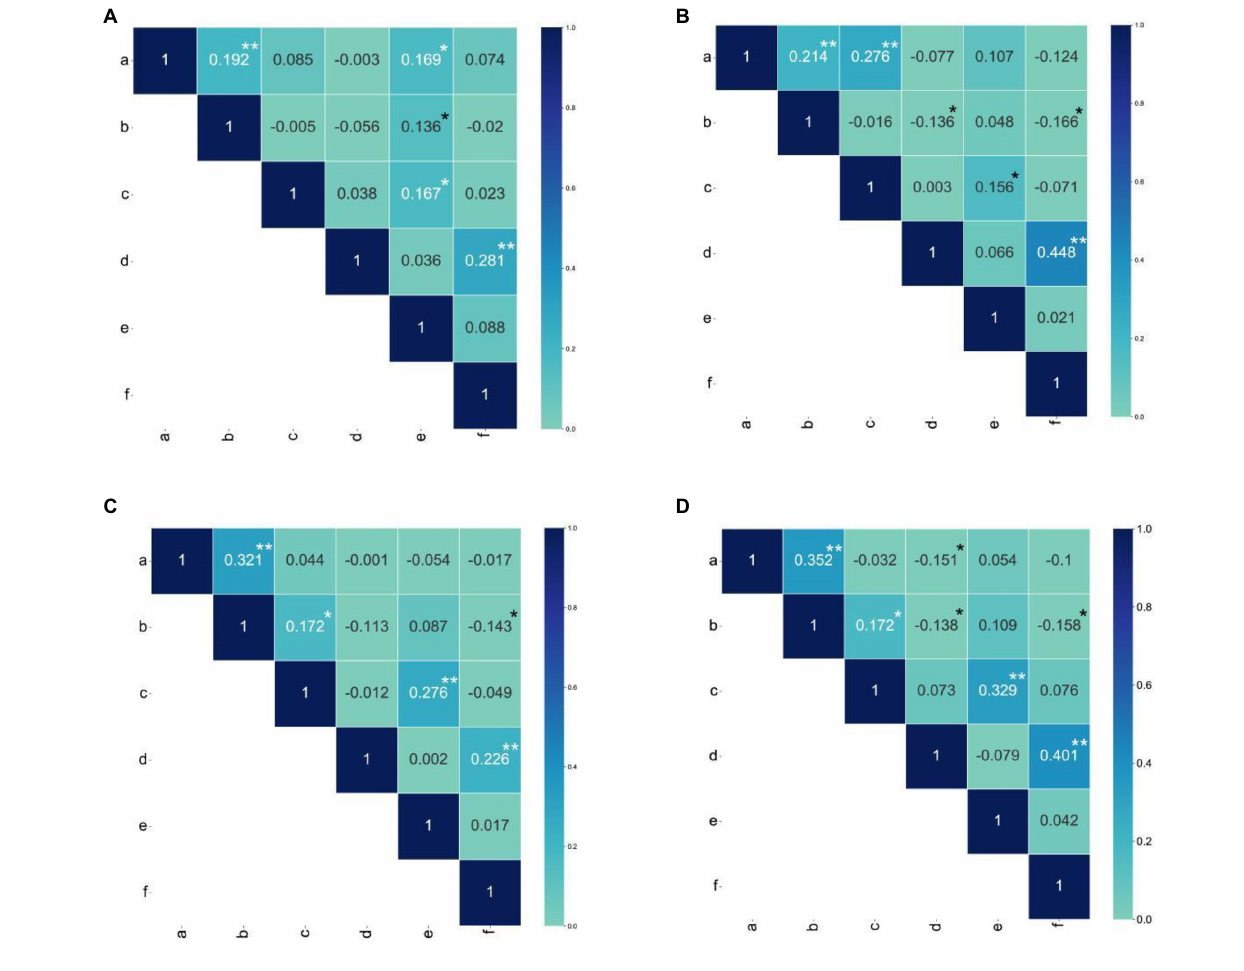
FIGURE 3 | Pearson correlation coefficients among all photoperiod sensitivity traits. (A) Pearson correlation coefficients for photoperiod sensitivity traits between Hainan and Changchun in 2018. (B) Pearson correlation coefficients for photoperiod sensitivity traits between Hainan and Gongzhuling in 2018. (C) Pearson correlation coefficients for photoperiod sensitivity traits = between Hainan and Gongzhuling in 2019. (D) Pearson correlation coefficient for photoperiod sensitivity traits between Hainan and Changchunin, 2019. The a, b, c, d, e, and f in the figure represent PHPS, EHPS, LNPS, LEPS, SSPS, and ATPS, respectively. The asterisks (* or **) represent the significant differences at p < 0.05 or p < 0.01,